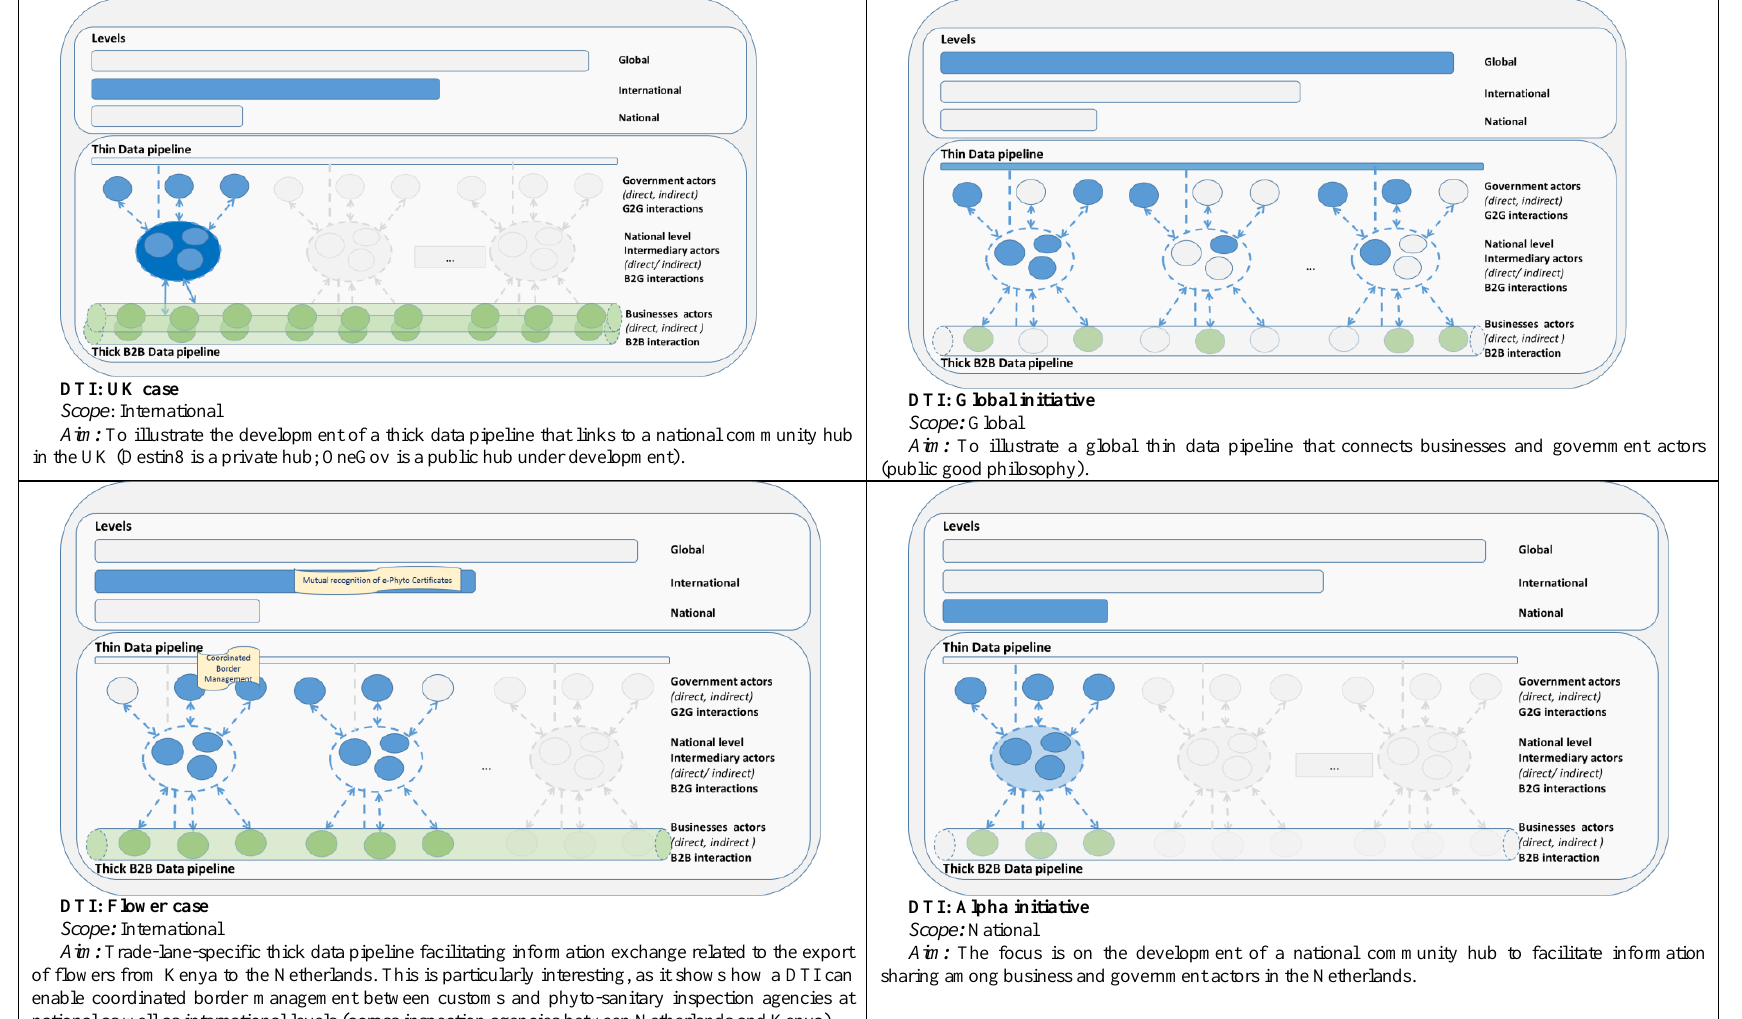
Figure 2. Use of the architecture component of the DTI framework to describe the four